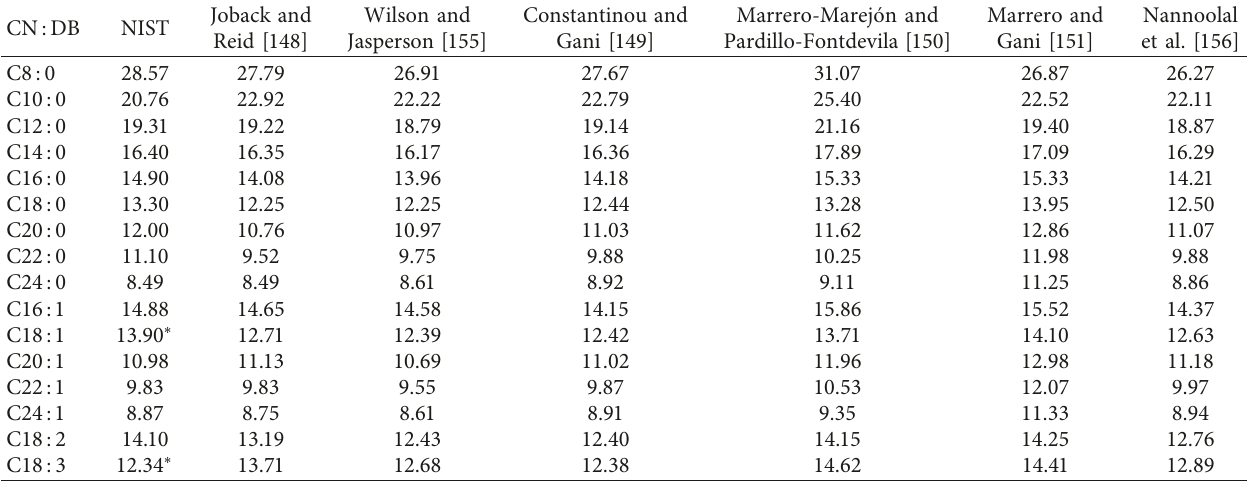
Table 14: Comparison of experimental and estimated critical pressure (bar).